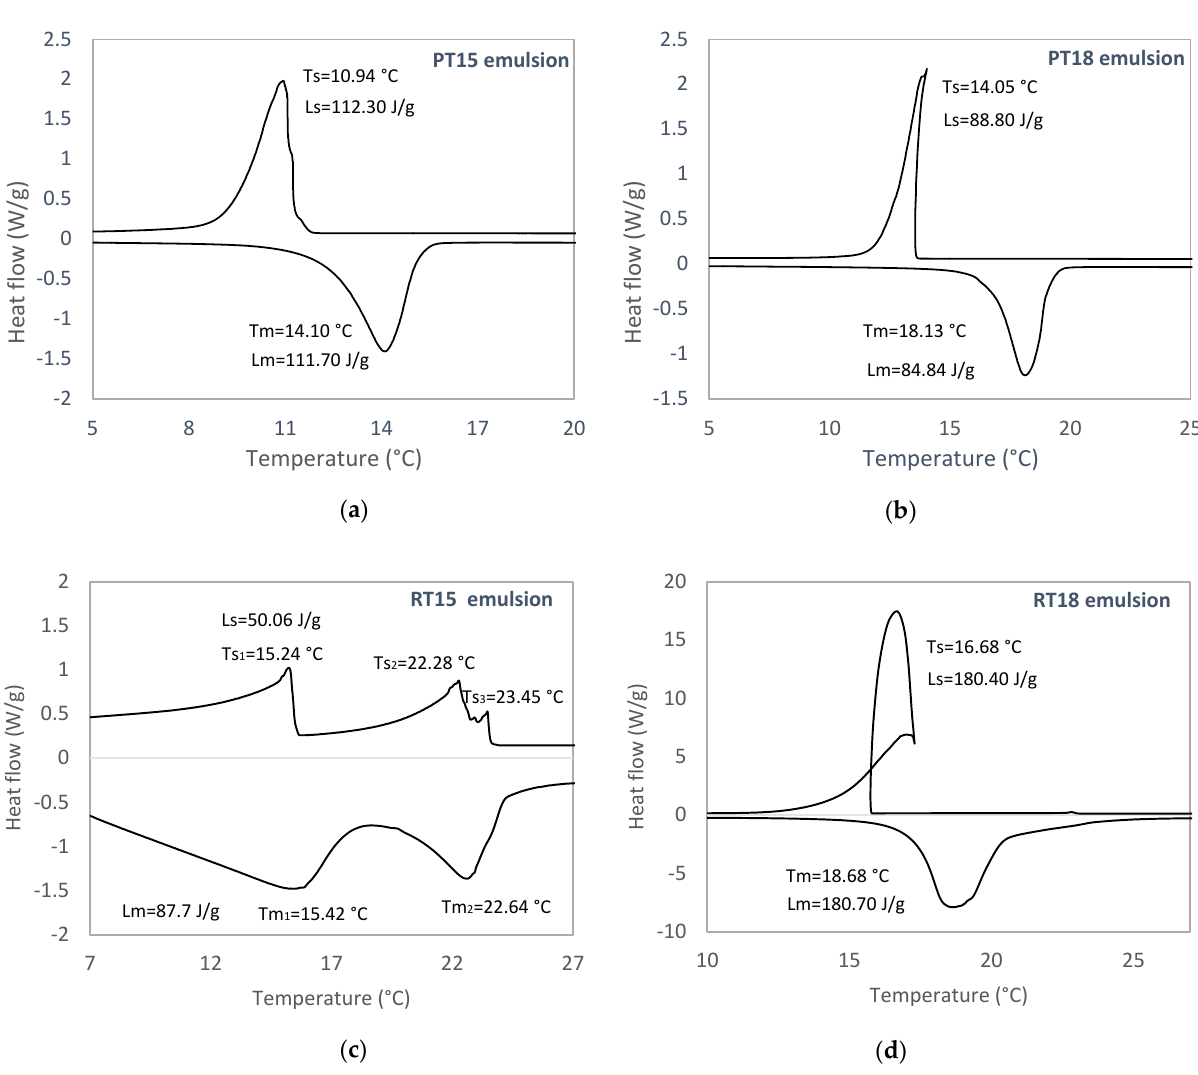
Figure 3. DSC thermogram of ( a ) PT15 ( b ) PT18 ( c ) RT15, ( d ) RT18 in water emulsions in their 1st thermal cycle. Obtained melting/solidification temperatures and enthalpies are shown.